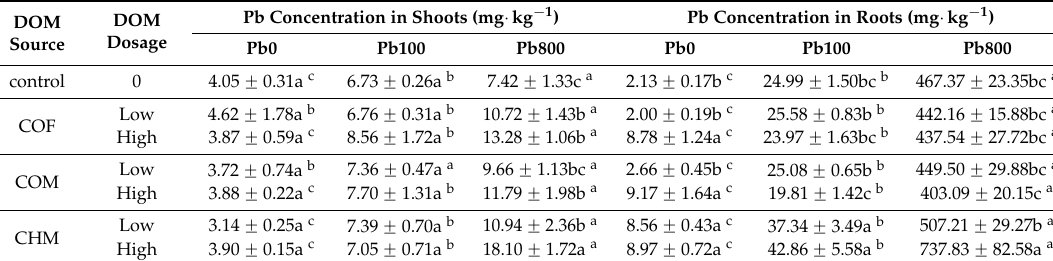
DOM: stands for dissolved organic matter; COF: represents commercial organic fertilizer; COM: cow manure; CHM: chicken manure; Pb0, Pb100 and Pb800 denote the pot soils to which 0, 100 and 800 mg ¨ kg ´ 1 Pb were added, respectively. The different superscript letters in the same row indicate significant difference in Pb concentrations ( p < 0.05) among the soil Pb levels according to the LSD (Least Significant Difference) test. The different letters following the data in the same column indicate significant difference in Pb concentrations ( p < 0.05) among DOM treatments according to the LSD test. Data are means ˘ SE ( n =